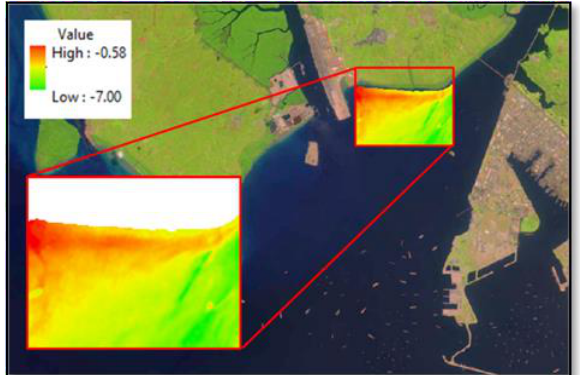
Figure 11. Imagery-derived bathymetric model (study area) from Stumpf et al’s band ratio approach.